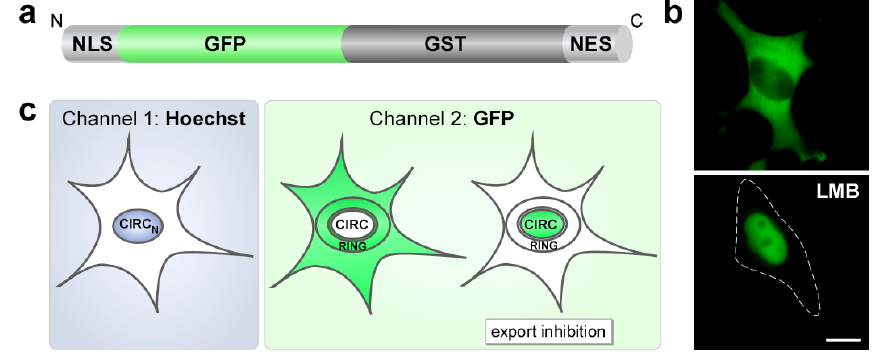
Figure 2. (a) Schematic representation of the modular RevNES-biosensor. (b) In living HeLa cells transiently expressing the RevNES-biosensor, the protein